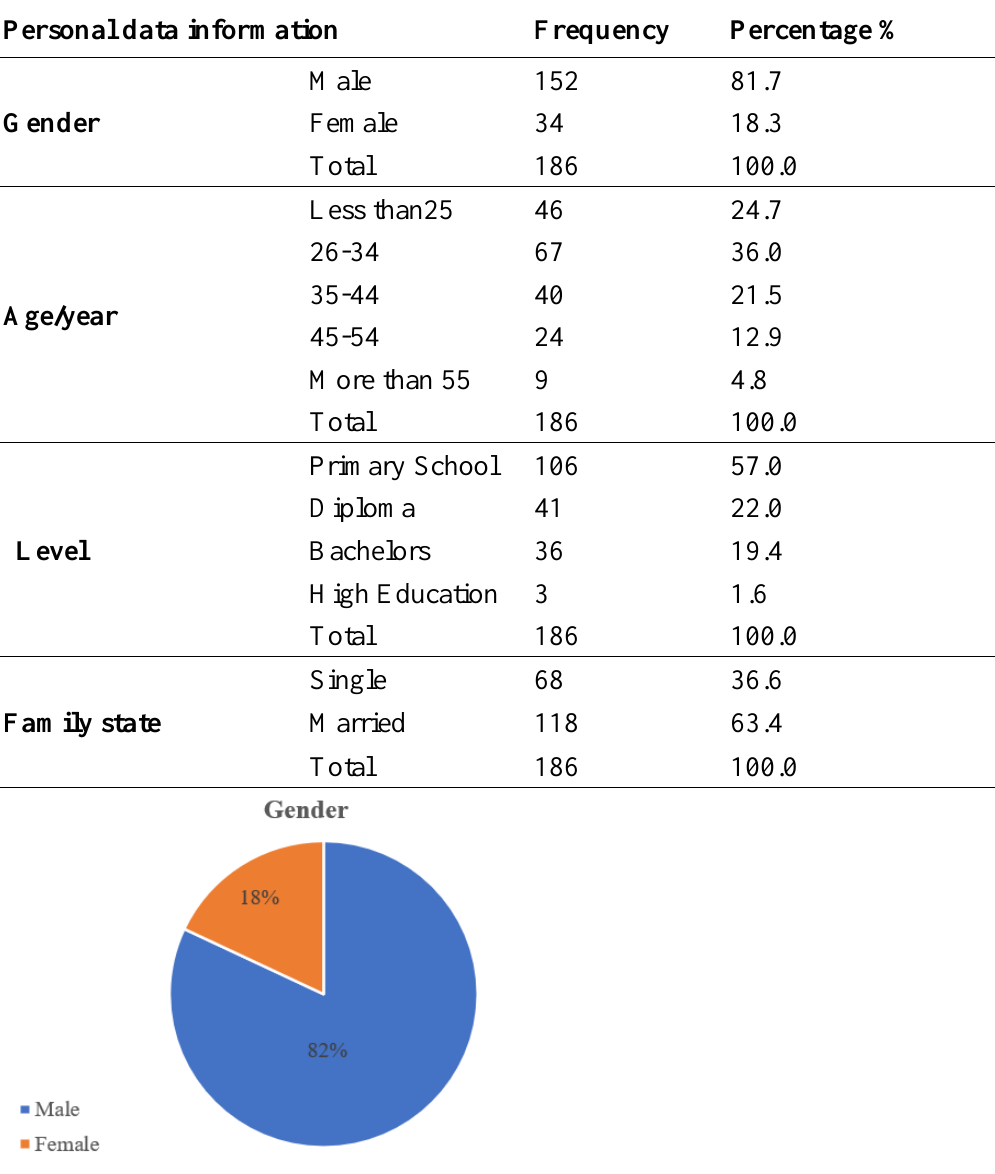
Table 3. Frequencies and percentages for the axis (personal data)